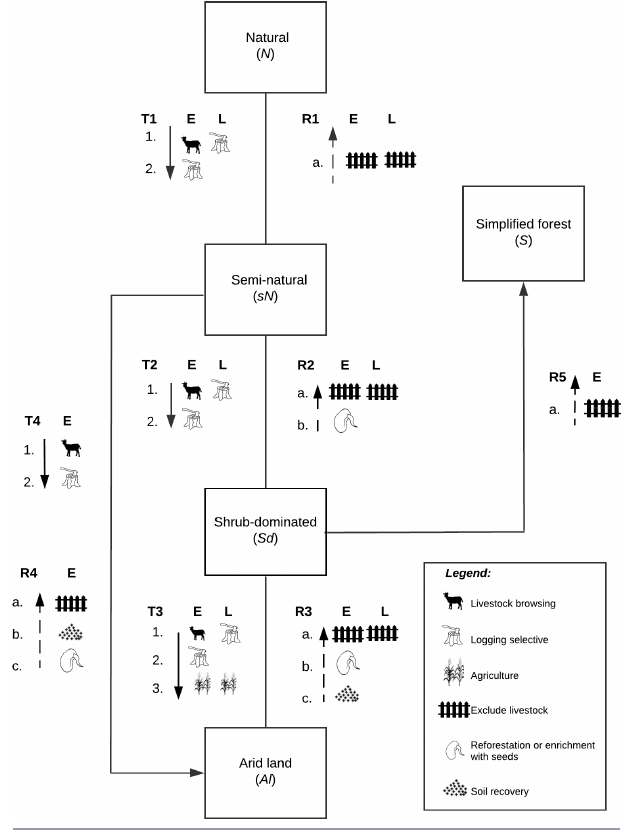
Fig. 3. State-transition model for the Zapotillo dry forest ecological site with the five forest states identified. Solid arrows represent transition possibilities (T1, T2, T3, T4); broken arrows represent chances of recovery (R1, R2, R3, R4, R5). Drivers of each transition, as well as management actions to reverse the disturbance process, are differentiated for ecologists’ (E) and locals’ (L) opinions and ordered by the frequency with which they were